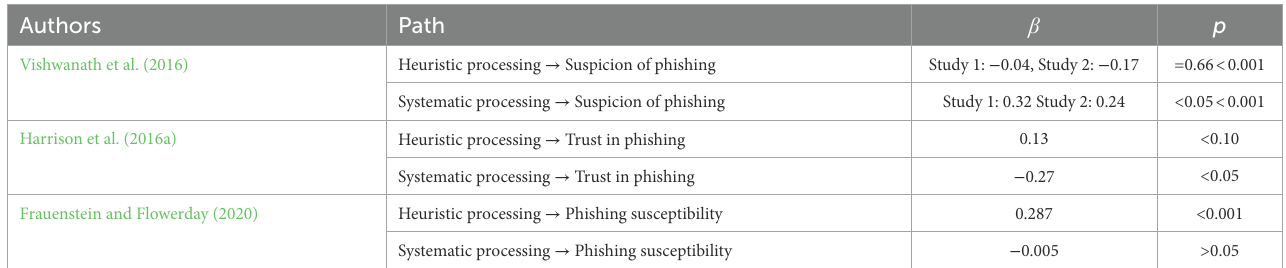
TABLE 2 Path analysis of heuristic-systematic processing and data